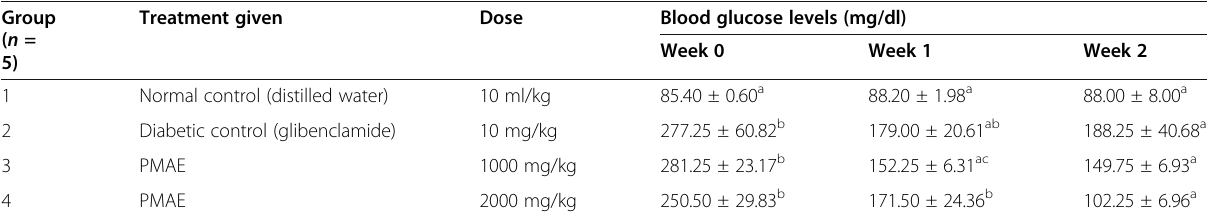
Table 3 Effect of aqueous stem bark extract of P. macrophylla on blood glucose levels in alloxan-induced diabetic Wistar rats Group ( n =